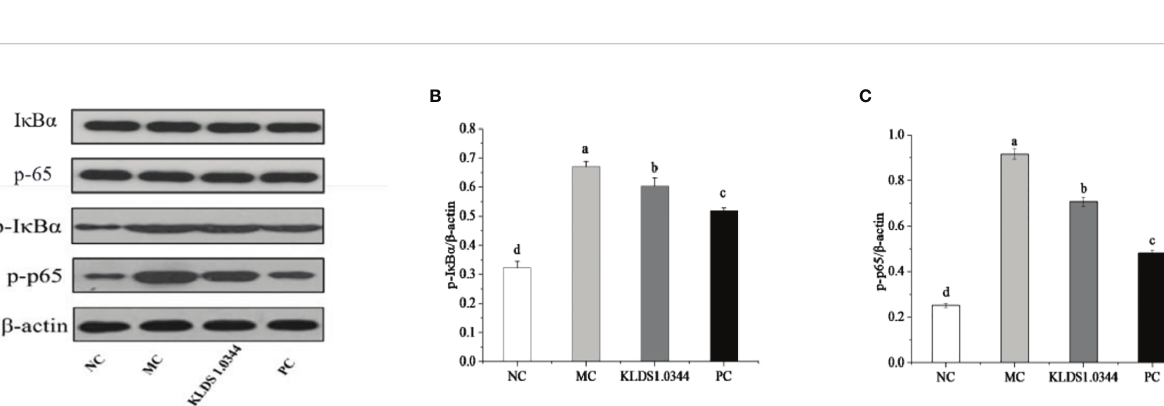
FIGURE 5 | Effects of pretreatment of KLDS 1.0344 on the expression levels of IL-6 (A) , TNF- a (B) , and IL-1 b (C) in breast tissue. NC, normal control group; MC, LPS-induced mastitis group; KLDS1.0344, KLDS1.0344 pretreatment group, PC, pretreated with dexamethasone group. Values are mean ± SD. Means with no common letters differ signi fi cantly (P < 0.05).